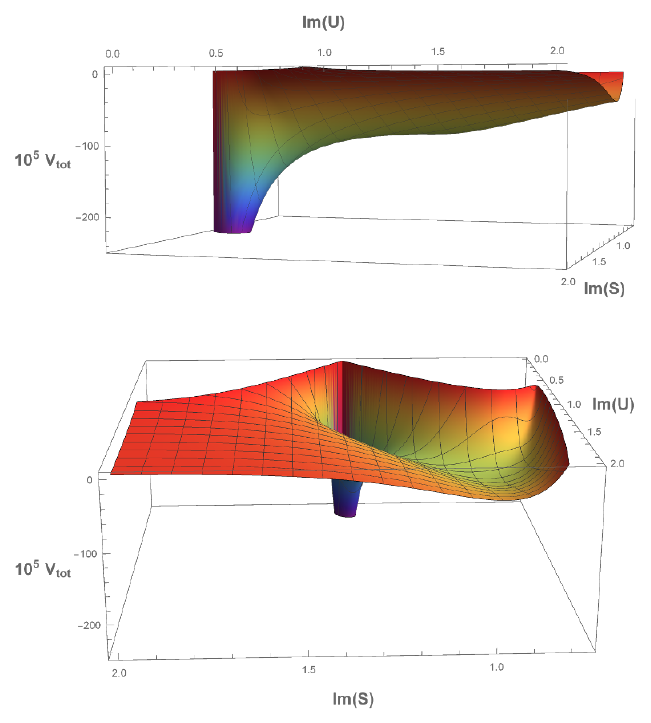
Figure 3 . The 3D plot for the anti-de Sitter scalar potential does exhibit a stable minimum. However, after the uplift using a anti-D6-brane this will lead to a